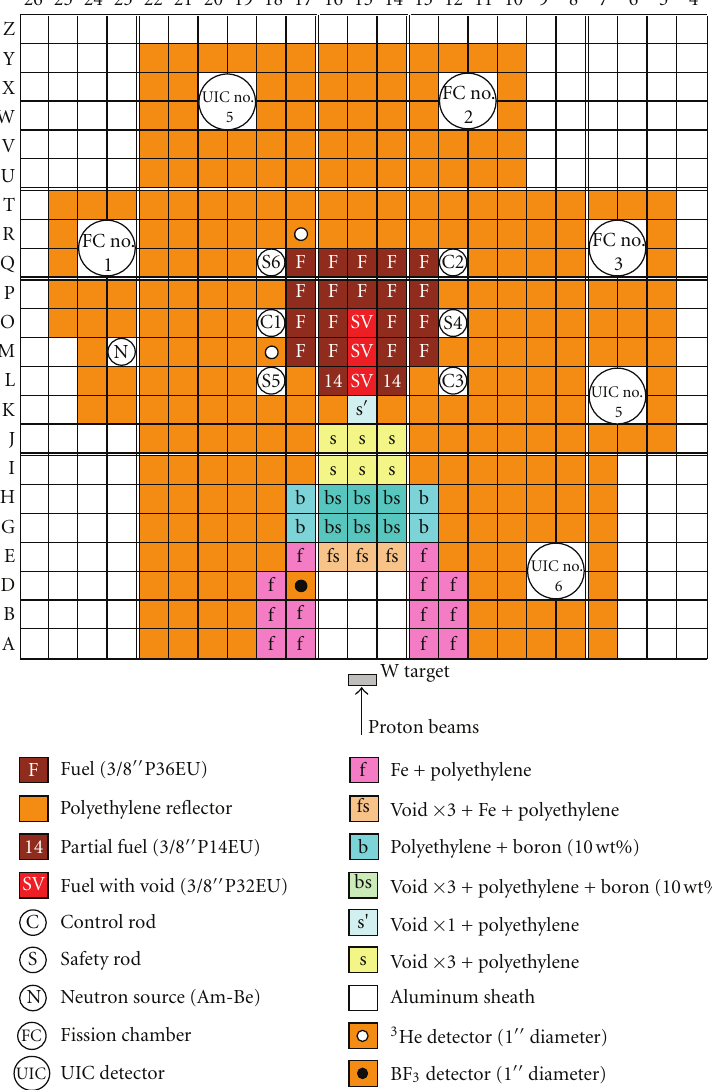
Figure 1: Top view of the KUCA A-core (A3/8 (cid:2)(cid:2) P36EU(3)) in the ADS